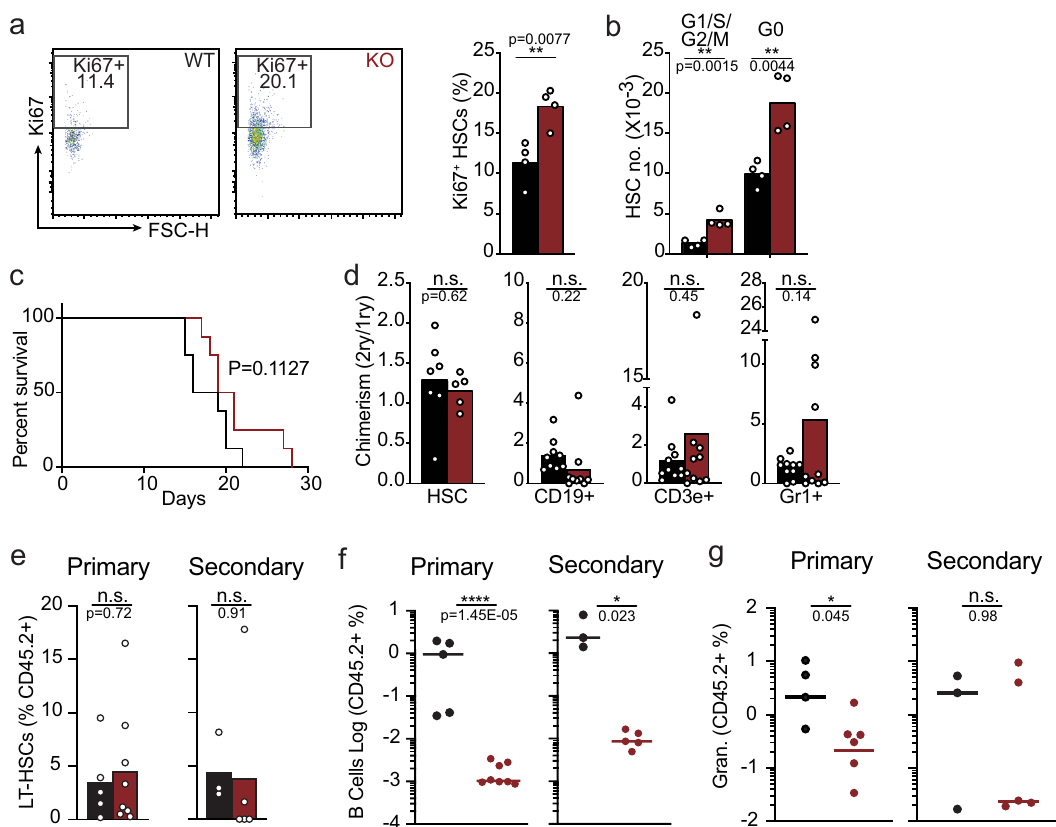
Fig. 2 | Measurement of HSC quiescence and self-renewal in mice with CXCR4- de fi cient MPPs. a , b HSC cell cycle status. a Gating strategy and cell frequency ( n =4 mice/group); ( b ) Enumeration of HSCs in G0 (Ki67 - ) and in G1/S/G2M(Ki67 + ) inbonemarrow( n =4mice/group). c Kaplan – Meyersurvivalplotofmicefollowing weekly 5-FU treatment (i.p., 150mg/kg, n =8 per group). a – c data obtained from Flk2-cre.Cxcr4 fl /+ (black) and Flk2-cre.Cxcr4 fl / fl (red) mice ( d ) Serial transplantation: Ratio of bone marrow chimerism in HSCs displayed as chimerism in secondary transplantation divided by chimerism in primary transplantation. Mice were